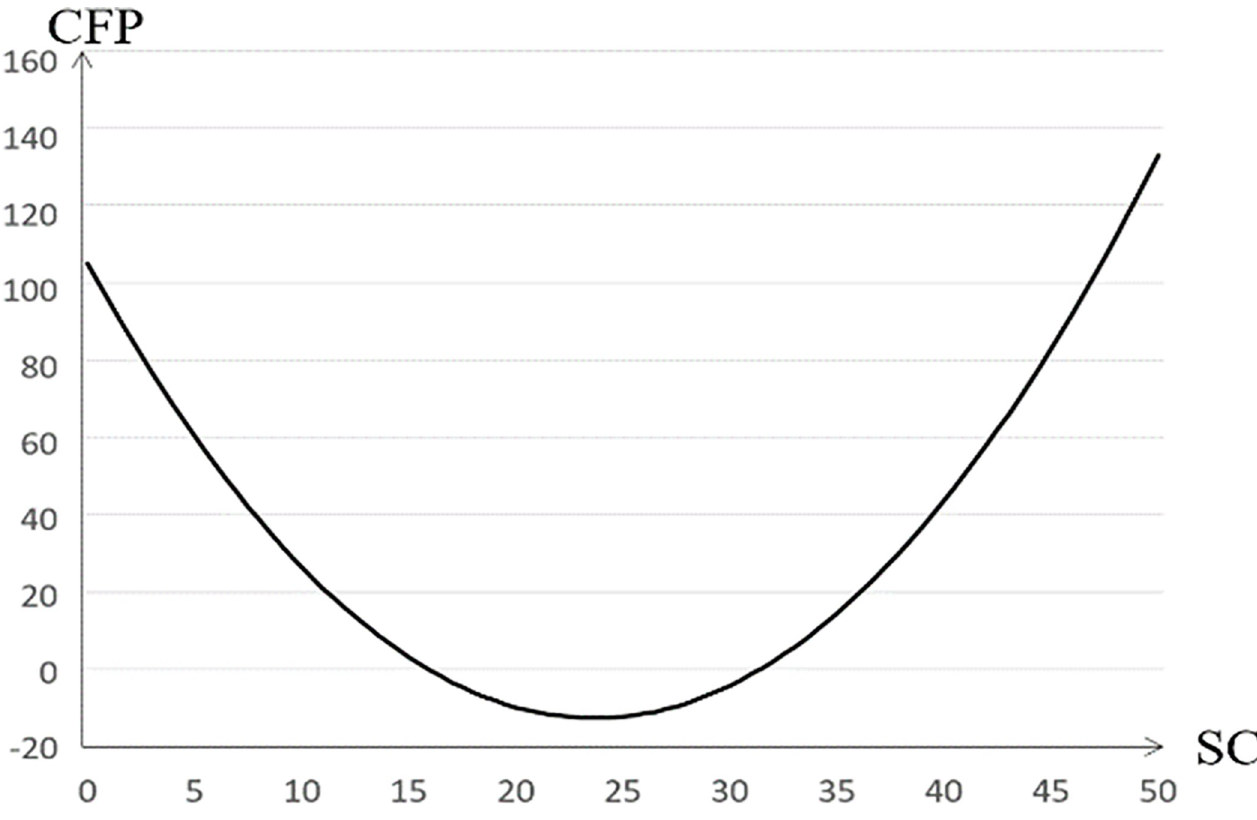
Fig 2. The relationship between company size and company